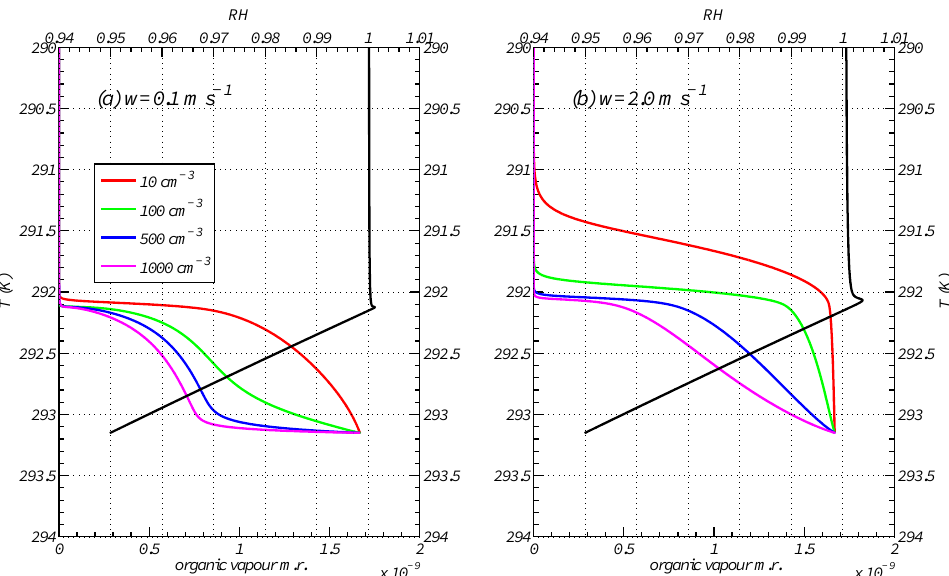
Fig. 2. (a) shows the organic vapour content in the parcel plotted against temperature (coloured lines) for parcel model simulations assuming an updraft speed of 0 . 1ms − 1 . The different coloured lines correspond to parcel model simulations that contain different total aerosol number concentrations (as in the legend). The black line is the humidity for the simulation with 1000cm − 3 aerosol particles. (b) is the same as for (a) but for an updraft velocity of 2 . 0ms − 1